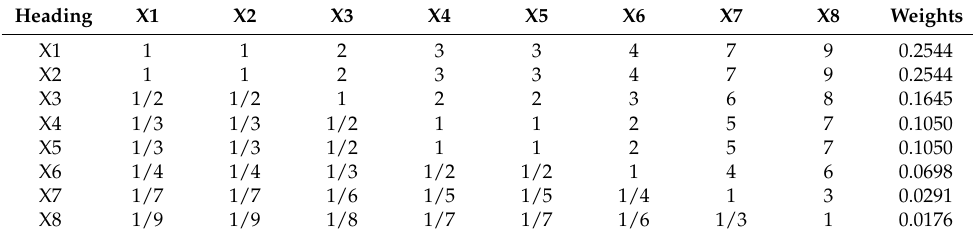
Table 3. Pair-wise comparison matrix for influencing factor